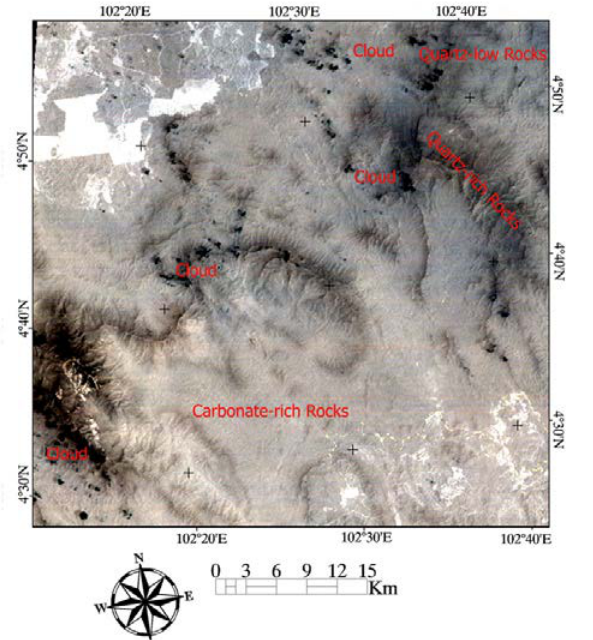
Figure 5. Fused image map of QI, CI and MI indices as RGB color combination derived from ASTER level 1B product for the study area.